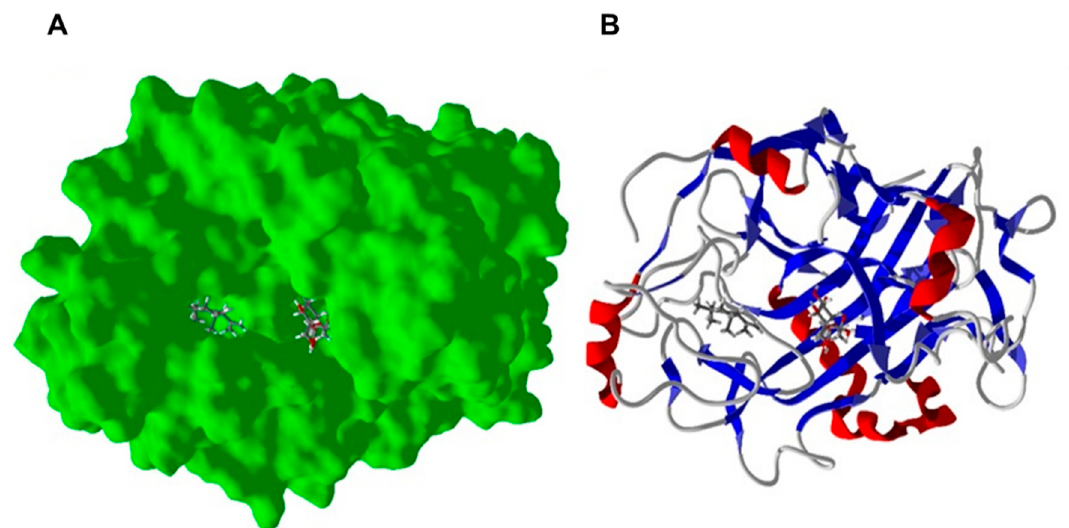
Figure 7. Lowest-energy docked pose of δ -elemene (left stick figure) with Fusarium oxysporum endoglucanase (Protein Data Bank, PDB 4OVW). The co-crystallized ligand (right stick figure) is 4-( β -D-glucopyranosyloxy)-2,2-dihydroxybutyl propanoate. ( A ): Solid protein structure. ( B ): Ribbon structure.